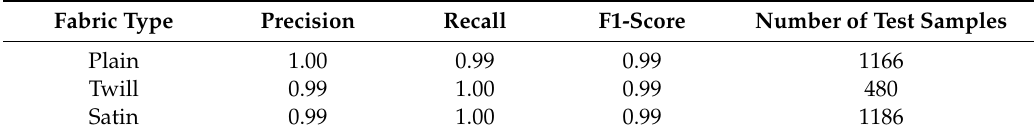
Table 1. The classification report generated on the test dataset.